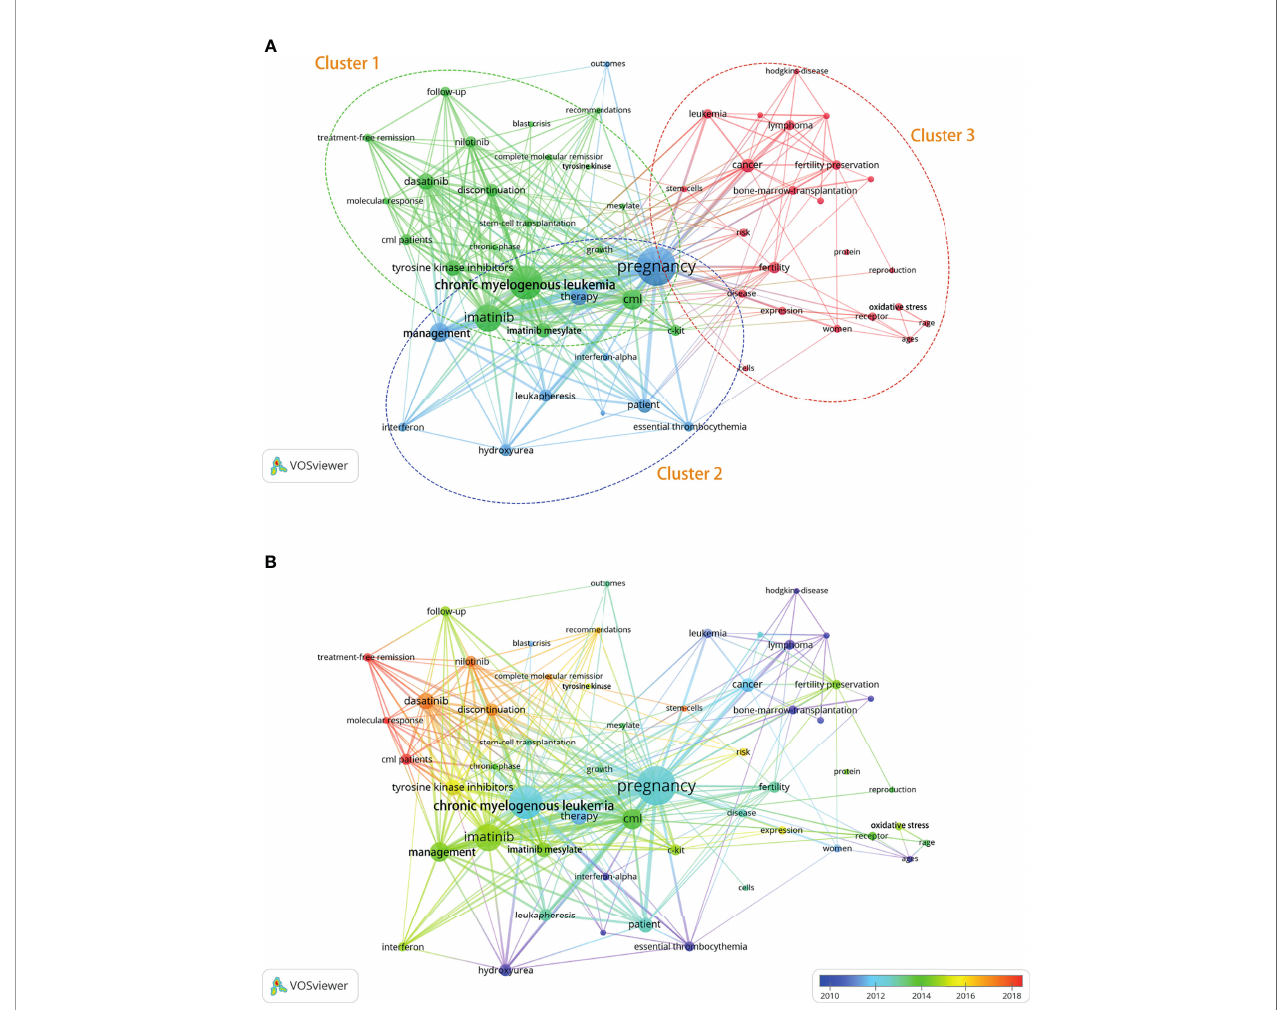
FIGURE 9 | Distribution of keywords (frequency >5). (A) Network map of keyword frequency. (B) Trends in keyword frequency over